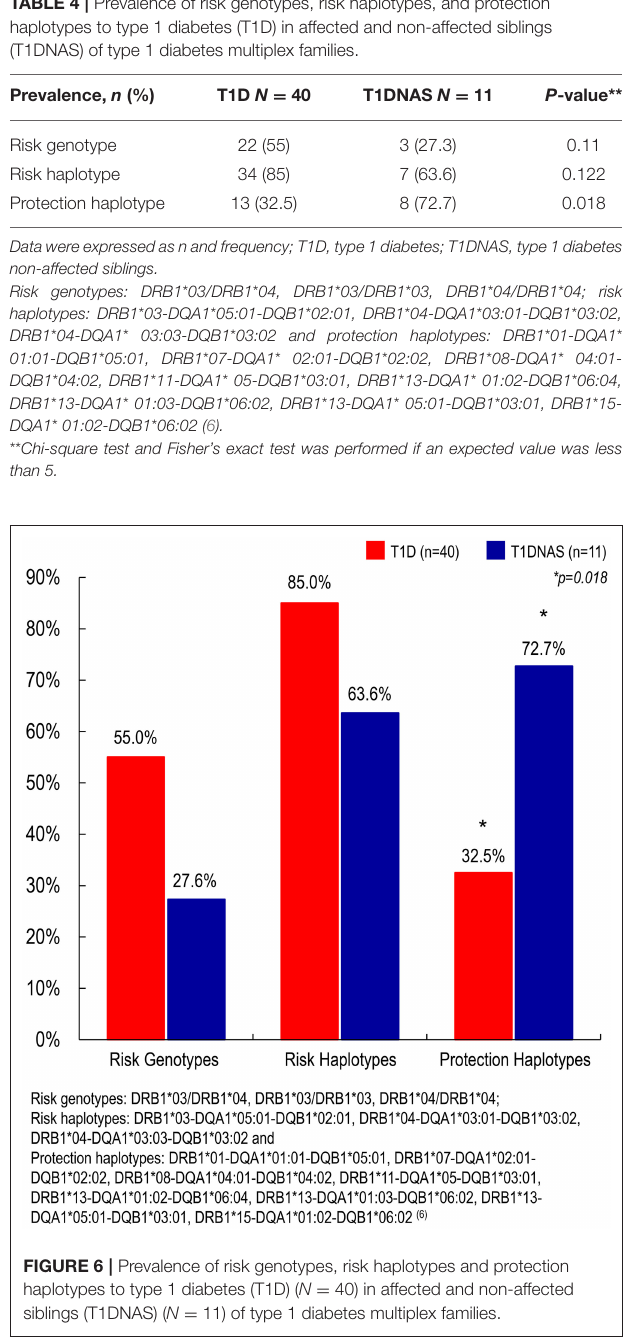
FIGURE 6 | Prevalence of risk genotypes, risk haplotypes and protection haplotypes to type 1 diabetes (T1D) ( N = 40) in affected and non-affected siblings (T1DNAS) ( N = 11) of type 1 diabetes multiplex